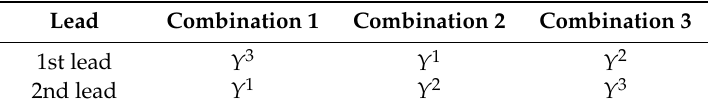
Algorithm 1. The algorithm of two convolutional stages of the DL-CCANet.